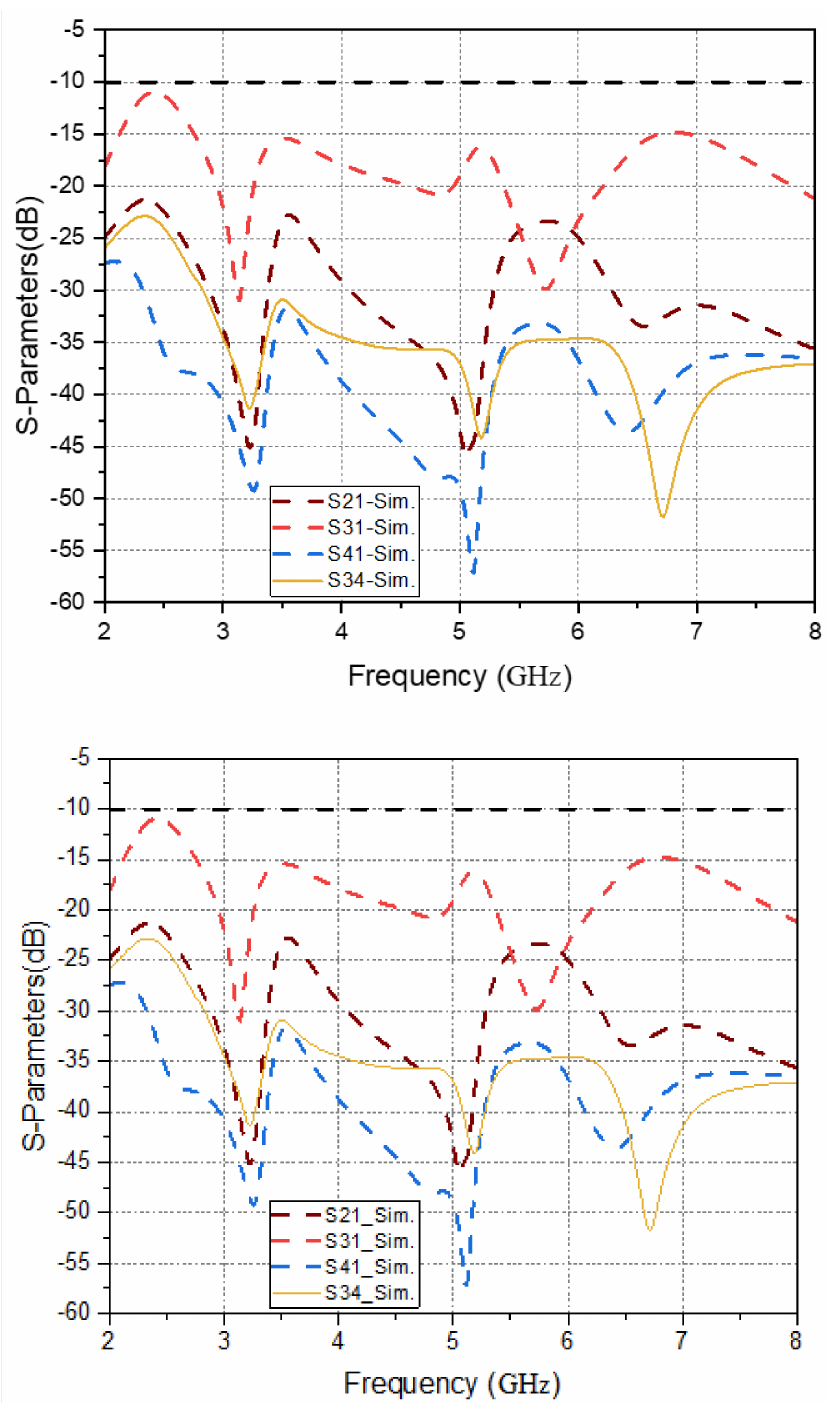
Figure 13. Isolation for final proposed size of antenna system (|S21|, |S31|, |S41|,